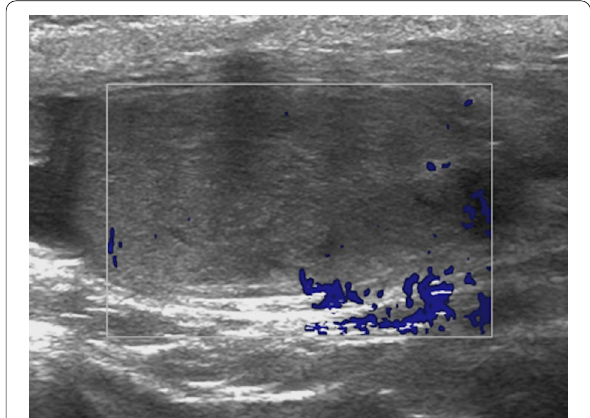
Fig. 4 Mumps orchitis. A 32-year-old man referred from infertility clinic for general evaluation and mildly enlarged left testis. US exam demonstrated severely heterogeneous left testis with no evident vascularity within the testis parenchyma. The right testis was completely normal (not shown). Orchiectomy revealed severe and diffuse testicular fibrosis consistent with chronic mumps